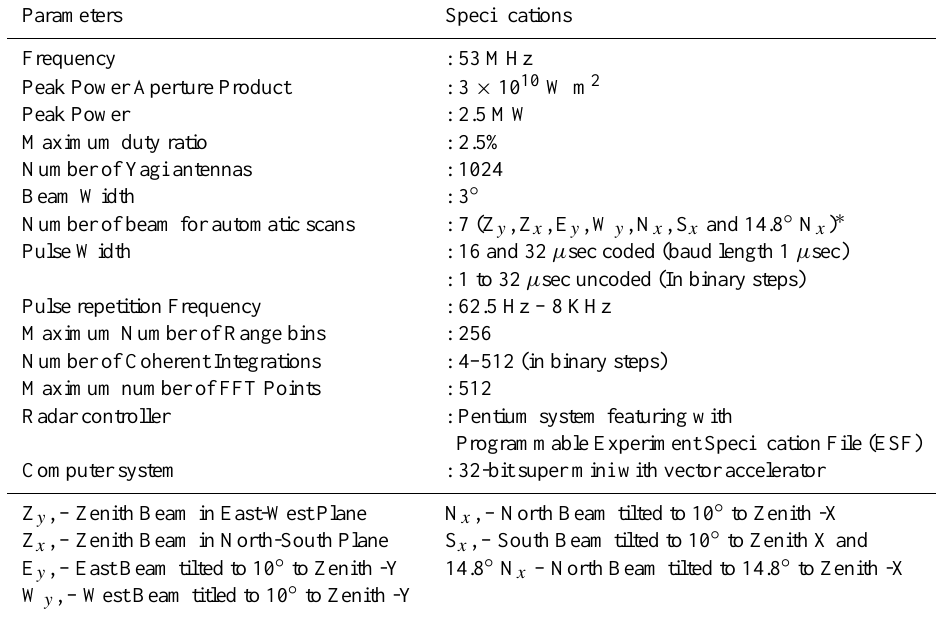
Table 1. Major specifications of the Indian MST radar